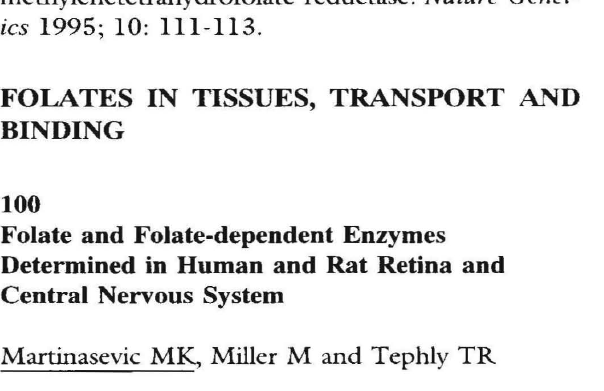
(1) Frosst Pet, ai., A candidate genetic risk fa.::· tor for vascular disease: a common mutation in methylenetetrahydrofolate reductase. Nature Gener